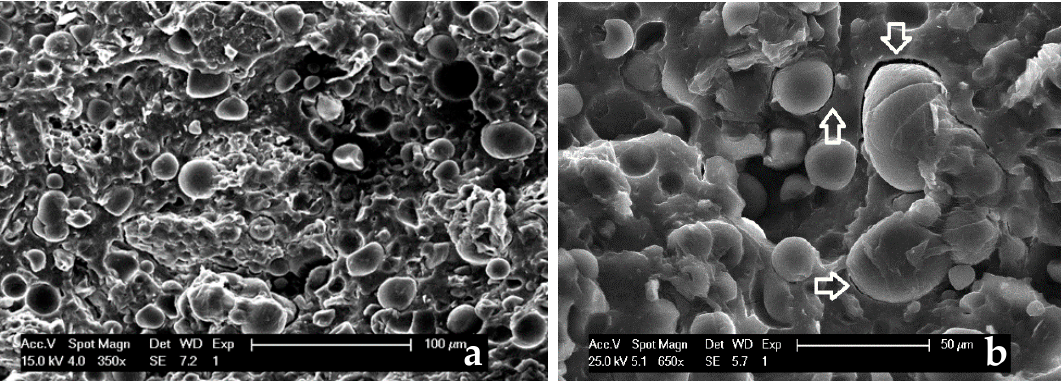
Figure 13. SEM picture of the biocomposite containing 20 wt% of sweet potato residue, ( a ) magnification 350×, ( b ) magnification 650×.